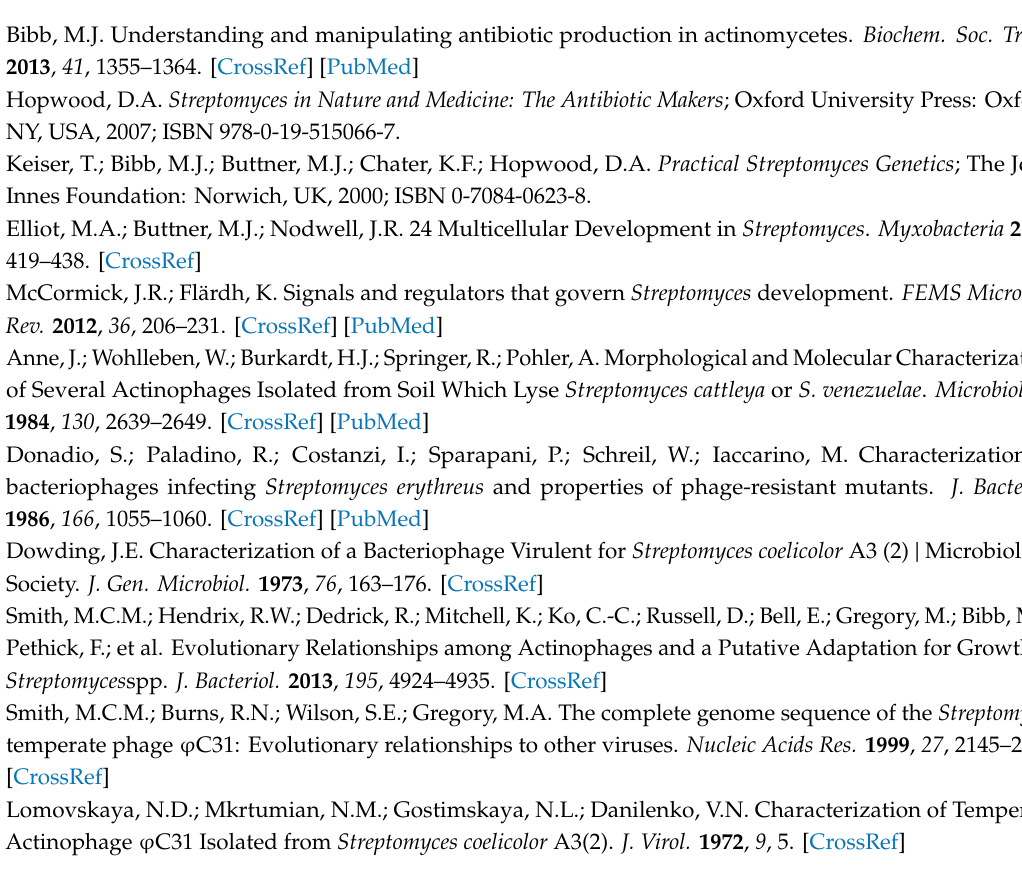
Figure S1: Close-ups of phage plaques imaged using a Nikon SMZ18 stereomicroscope, before (upper row) and after (lower row) exposure to ammonia fumes. Figure S2: VIRIDIC generated heatmap showing the intergenomic similarities of the newly sequenced phages with reference phages. Figure S3: Subclade dendrogram with Streptomyces phage Alderaan and its closely related actinophages. Figure S4: Subclade dendrogram with Streptomyces phage Coruscant and its closely related actinophages. Figure S5: Subclade dendrogram with Streptomyces phage Dagobah and its closely related actinophages. Figure S6: Subclade dendrogram with Streptomyces phages Endor1 and Endor2 and their closely related actinophages. Supplementary Table S1: List of the functional annotation of proteins ORFs within phage